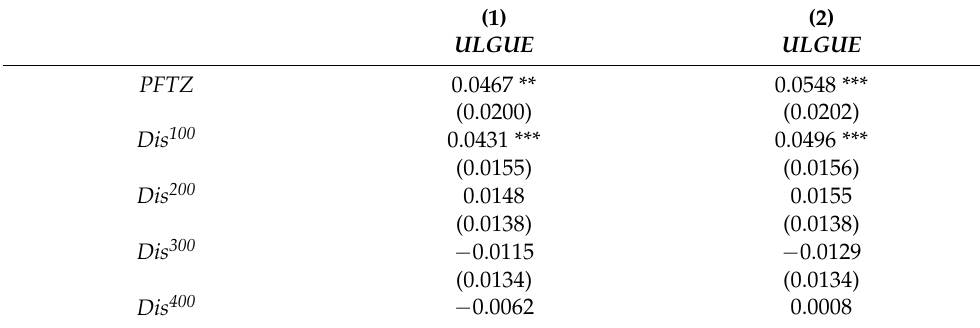
Table 11. Spatial spillover